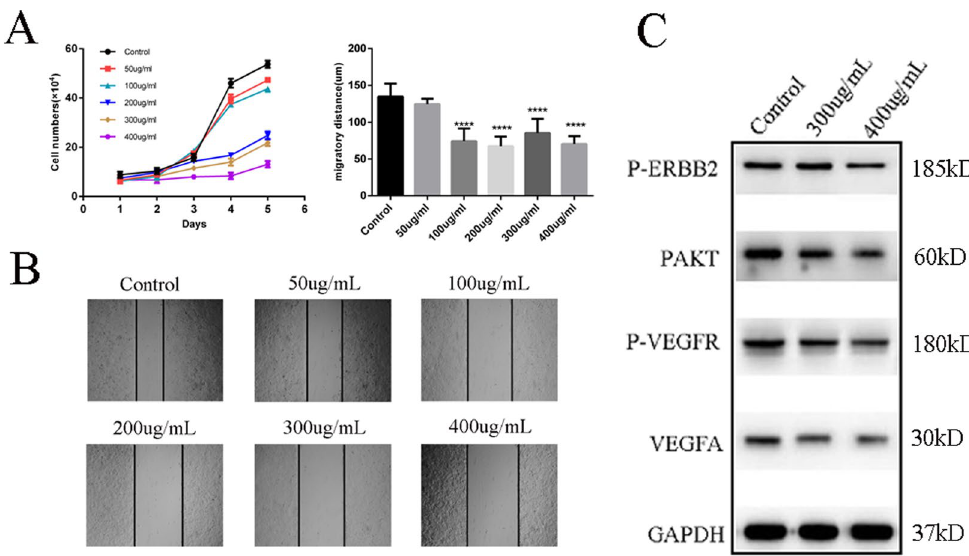
Figure 8. Effect of aqueous extract of 18 herbs on cell proliferation, cell migration and predicted targets. ( A ) The statistical views of cell proliferation (left) and cell migration (right). P-values are represented as asterisks ( **** P < 0,001). ( B ) The result of wound healing assay. ( C ) Western blot assay analyzed P-ERBB2, P-AKT1, VEGFA and P-VEGFR after the treatment of aqueous extract of 18 herbs. No grouping of gels/blots cropped from diferent parts of the same gel, or from diferent gels, felds, or exposures was